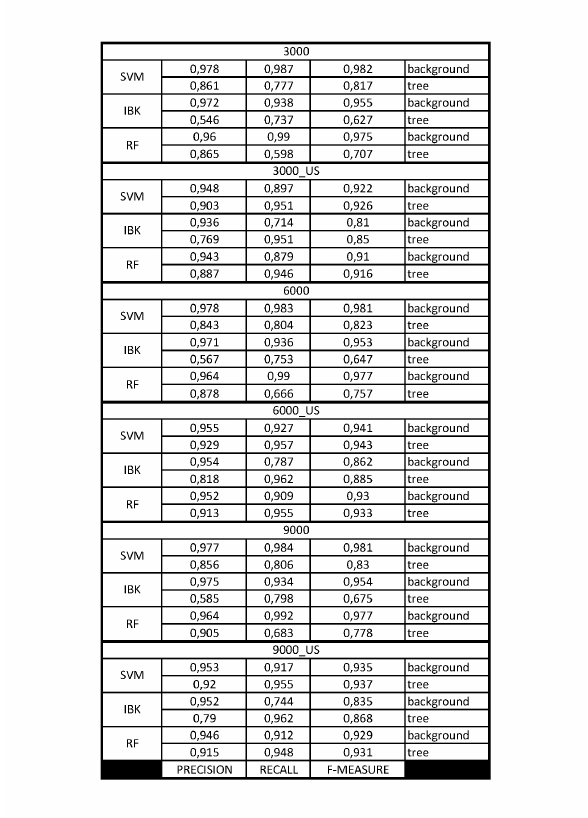
Figure 6. Comparison of Precision, Recall and F-measure by number of Superpixels, Balanced and